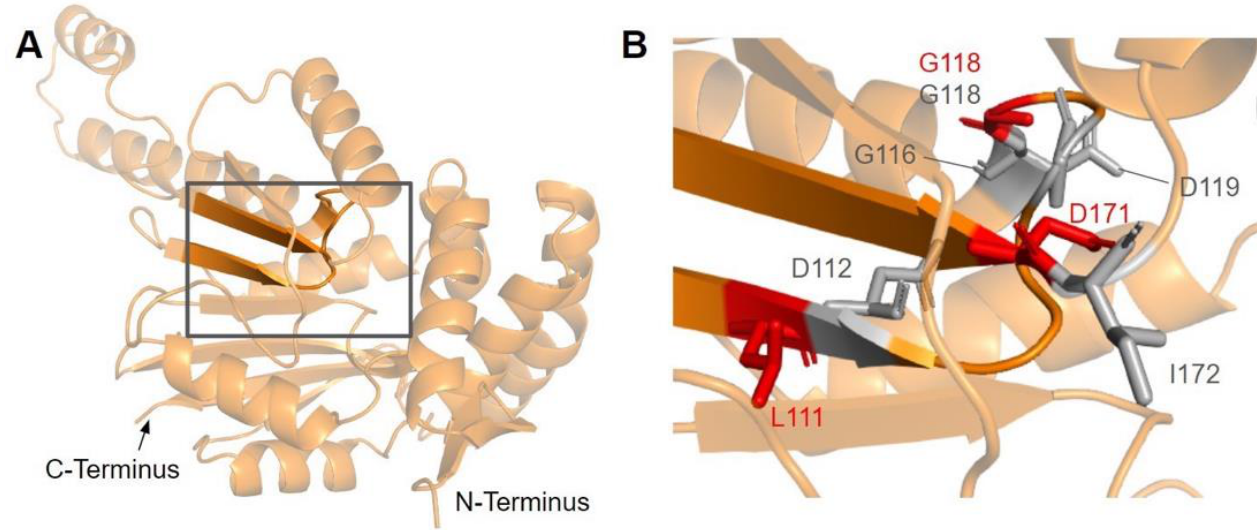
Figure 15. SNVs found in motif I and post-I of COQ5. ( A ) Motif I (lower β -strand, residues L110 to D119) and post-I (upper β -strand, residues V167 to D171) highlighted on the COQ5 model. The first 47 residues were truncated for simplicity. ( B ) Locations of SNVs in motifs I and post-I are depicted. Residues are colored according to their corresponding SNVs Figure 12.